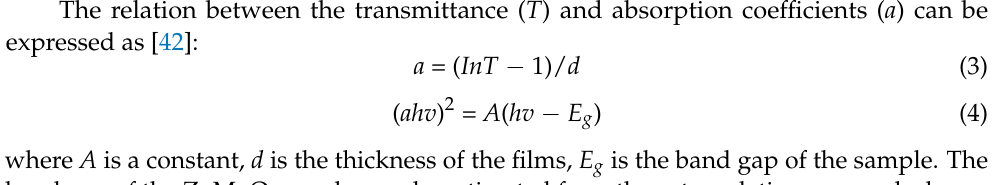
where A is a constant, d is the thickness of the films, E g is the band gap of the sample. The band gap of the ZnMgO samples can be estimated from the extrapolation approach shown in Figure 5.